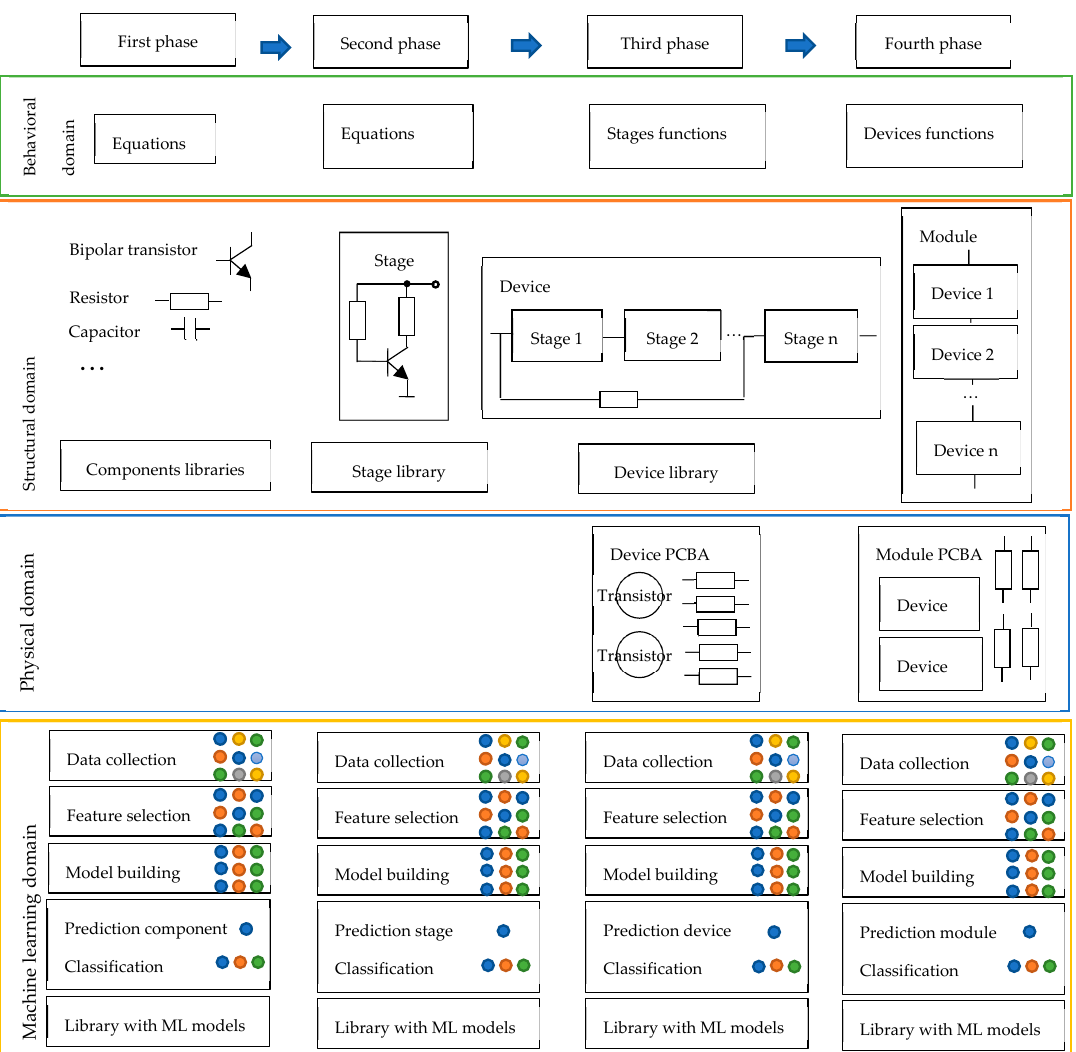
Figure 2. Framework for analog circuit design using machine learning.